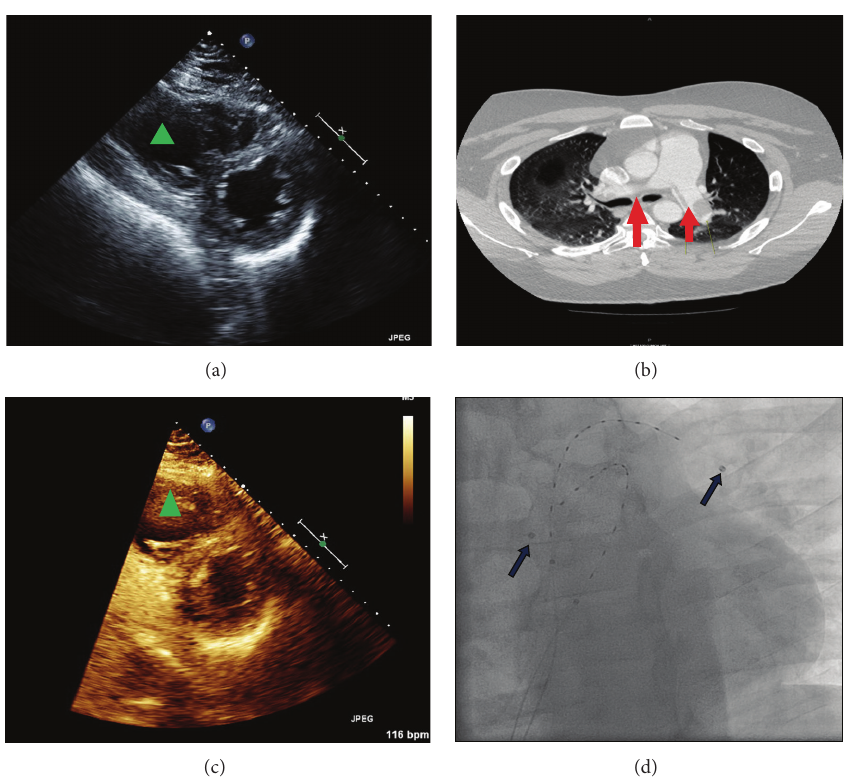
Figure 2: (a) The green triangle is located in the markedly dilated right ventricle. (b) The red arrows point at saddle emboli. (c) The echocardiogram shows improvement in the size of right ventricle. (d) The fluoroscopy confirms the placement of the UAT catheter in both main pulmonary arteries (blue